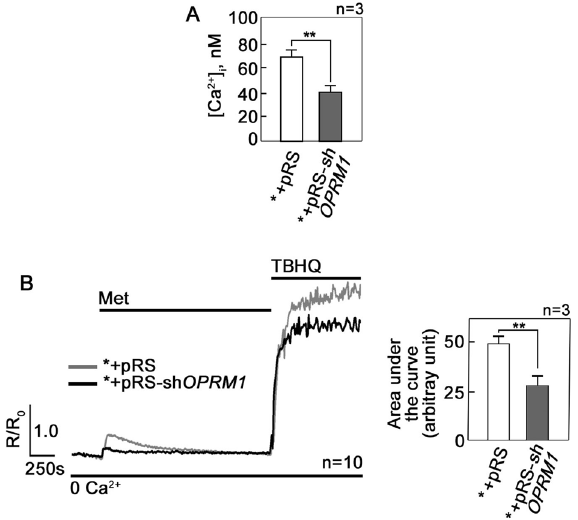
Figure 2. d,l-Methadone evokes Ca 2+ release from internal stores, causing increased [Ca 2+ ] i that is inhibited by loss of OPRM1. ( A ) Resting [Ca 2+ ] i levels in *+pRS and *+pRS-sh OPRM1 cells were measured as described in Materials and Methods. Values are means ± SEM from three independent experiments (n = 3). ** p < 0.018. ( B ) Cells loaded with Fura-2 AM and treated with d,l-methadone were analyzed for Ca 2+ transients in Ca 2+ -free buffer by ratiometric single-cell Ca 2+ imaging using a Shimadzu RF 5301PC spectrofluorometer as described in Materials and Methods. Values represent means of Ca 2+ signal traces in 10 cells from one of three independent experiments showing similar results (n = 3). Ca 2+ response following TBHQ addition indicates that cells were viable during the assay. Analysis of the Ca 2+ signal traces (left panel) indicates that d,l-methadone-induced increase in [Ca 2+ ] i is greater in *+pRS cells compared to *+pRS-sh OPRM1 cells. Values are means ± SEM from three independent experiments (n = 3). ** p <